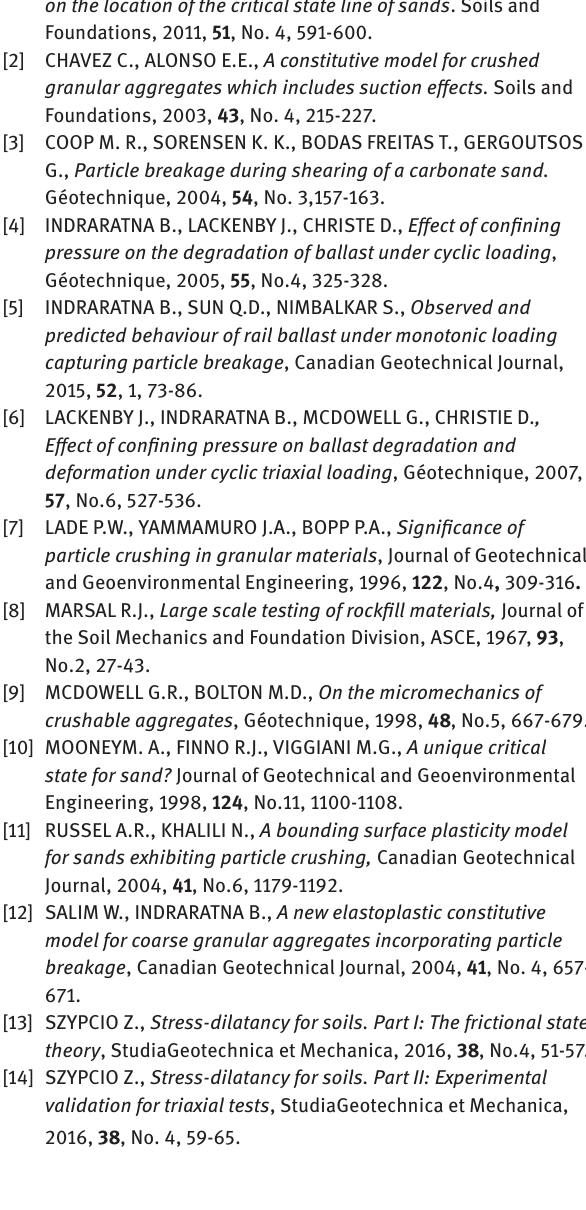
particles is mainly caused by shear deformation.